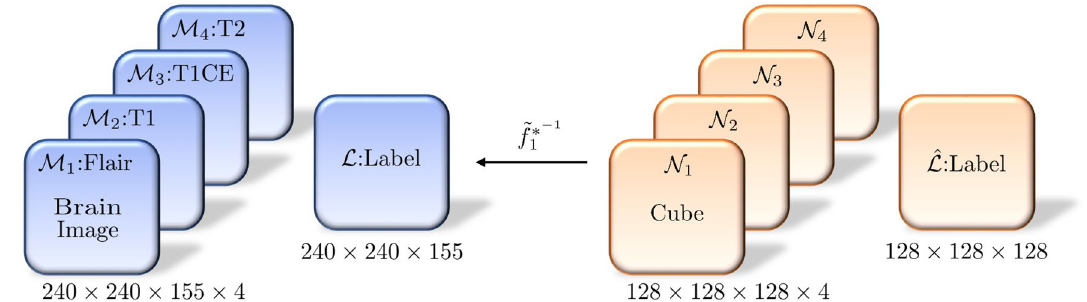
Figure 2. The TSOMT maps between 4-view brains and cubes with n